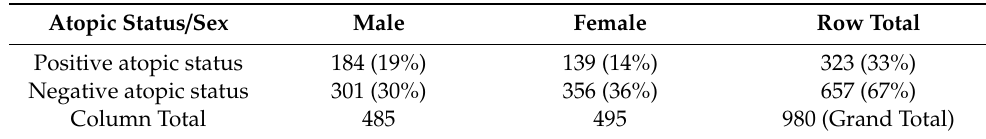
Table 4. Chi-square statistic of athletes’ atopic